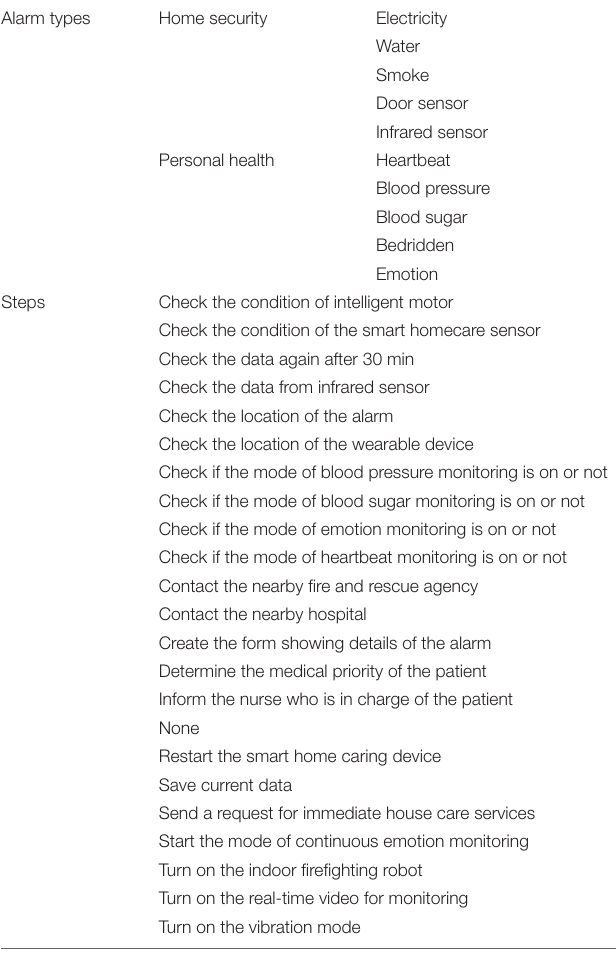
TABLE 1 | A list of 10 alarm types and 23 steps.